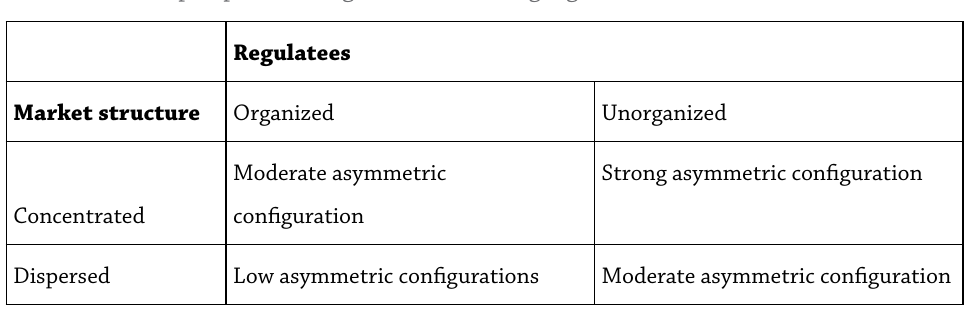
Table 1: A map of power configurations involving regulatees and market